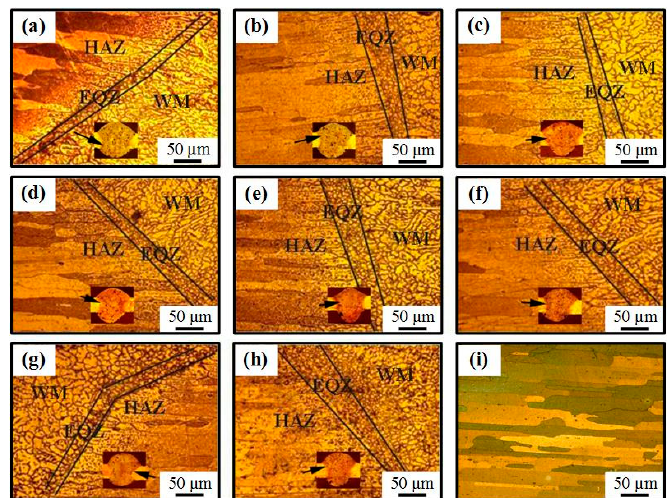
Figure 6. ( a – i ) The optical microstructure of the welded joints welded by ( a ) AC CMT and ( b ) AC CMT coupled current at frequency of 20 kHz, ( c ) 30 kHz, ( d ) 40 kHz, ( e ) 50 kHz, ( f ) 60 kHz, ( g ) 70 kHz, ( h ) 80 kHz and BM ( i ),